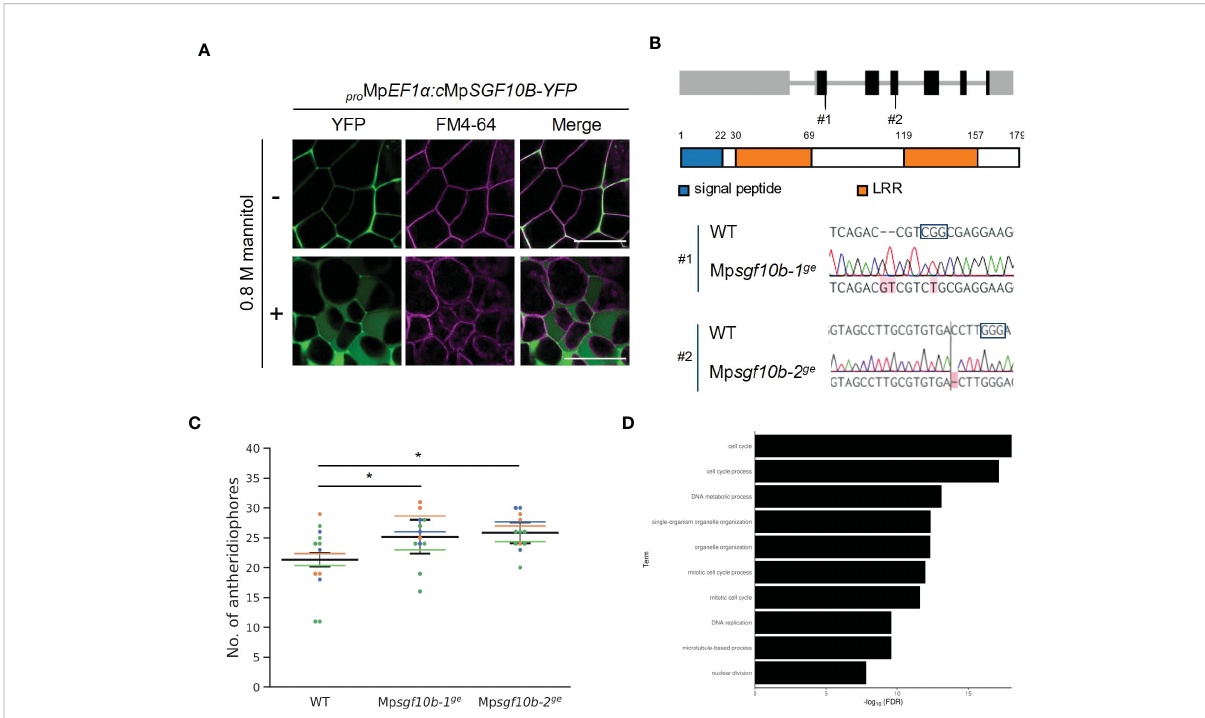
FIGURE 4 Reverse genetic analysis of MpSGF10B. (A) Subcellular localization of MpSGF10B-YFP constitutively expressed in M. polymorpha . Three-day-old gemmalings were observed. The plasma membrane was visualized with FM4-64 (magenta). Shown data are representative ones from 5 independent transgenic lines. Bars = 50 µm. (B) Gene structures and genotypes of Mp sgf10b mutants using CRISPR/Cas9. (top) Structure of MpSGF10B/Mp3g10170 locus with the positions of the designed guide RNAs (#1 and #2). Black boxes, gray lines, and gray boxes show coding exons, introns, and untranslated regions. (Middle) The predicted product of MpSGF10B is shown. (Lower) Sequences of genome editing alleles are shown. The PAM sequence is shown in enclosed characters. Edited bases are indicated with red shades. (C) The number of antheridiophores in an individual plant. n = 3, 3, and 5 for all lines from three independent experiments, respectively (indicated in distinct colors). Horizontal lines indicate the average numbers grouped by the experiments. Black lines show the total means ± SD. * P < 0.05, Dunnett ’ s test against wild type (WT). (D) GO enrichment analysis of highly co-expressed genes with Mp SGF10B . The 10 high-ranking biological processes are shown at a 1% false discovery rate